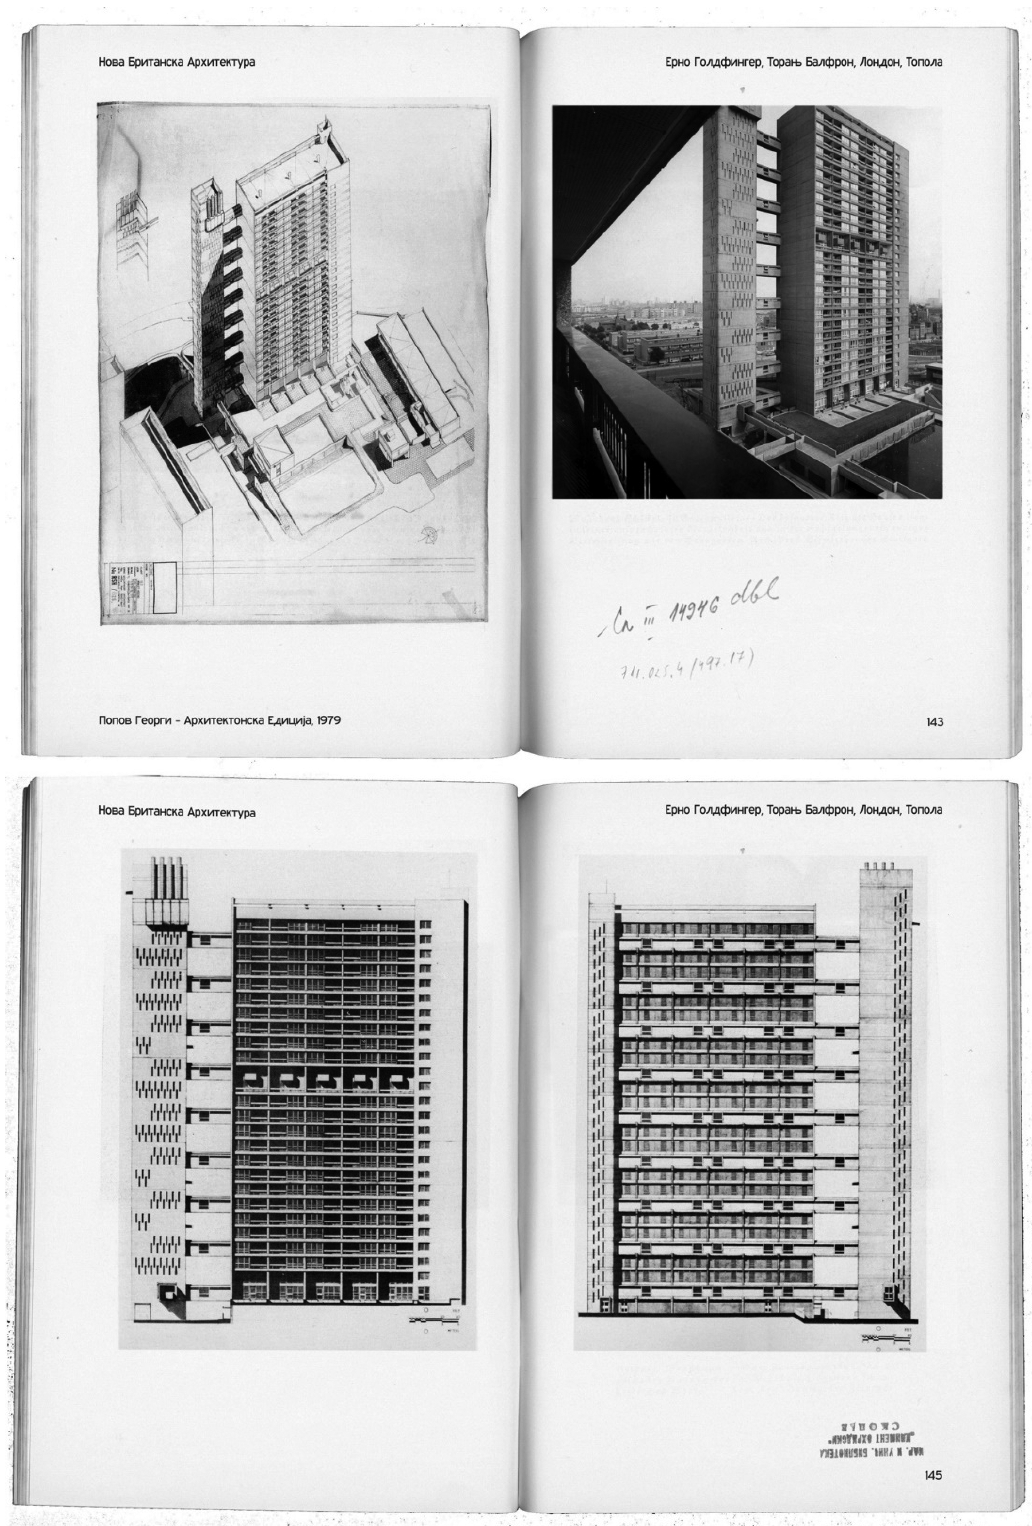
Figure 4. Georgi P. (1979), Nova Britanska Arhitektura , Architektonska Edizia, Novoselo.